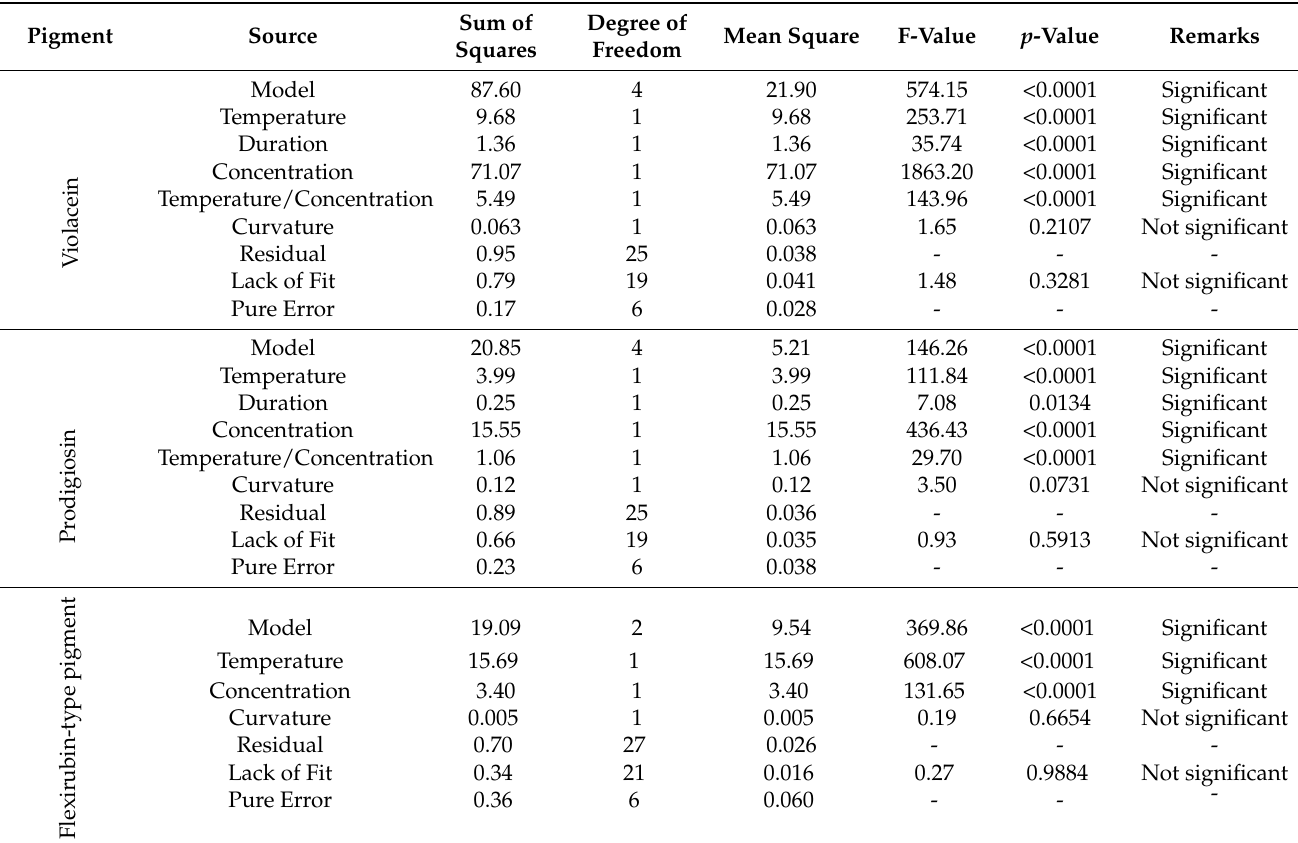
Table 3. Summary of ANOVA for the models based on full factorial